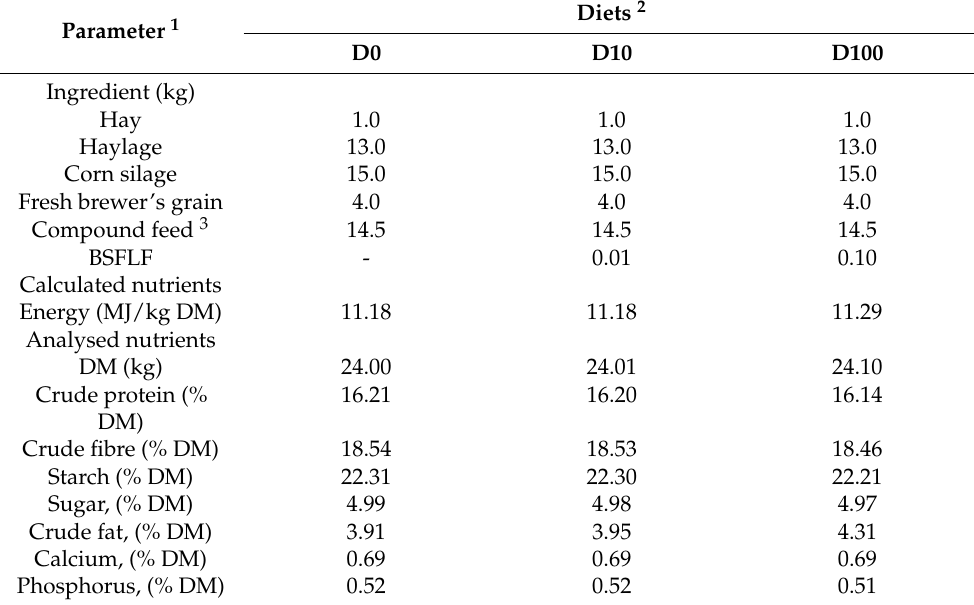
Table 1. Composition of experimental